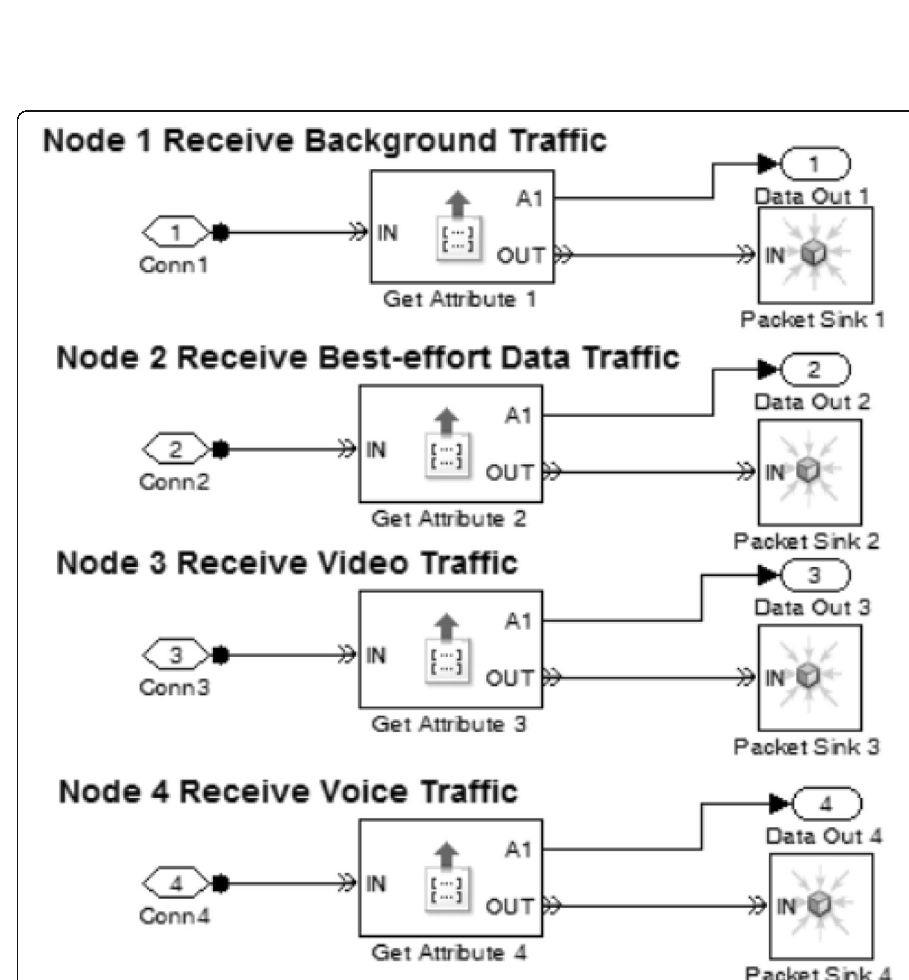
Fig. 9 Snapshot of the sink as implemented in MATLAB